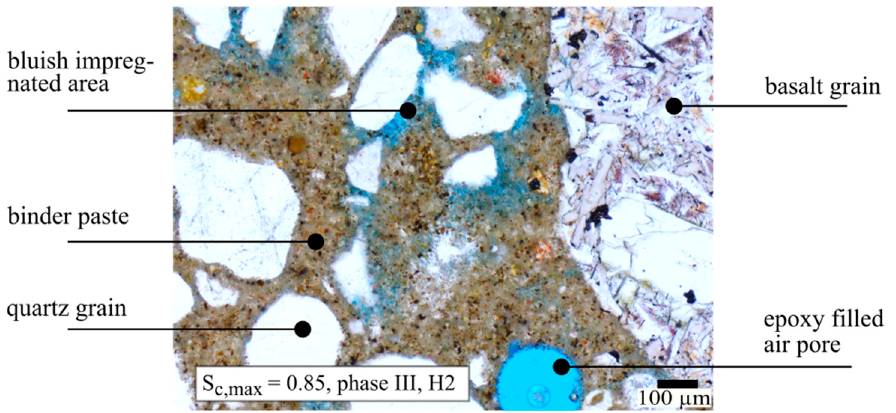
Figure 5. Light microscopic image of preloaded high-strength concrete (S c,max = 0.85, phase III, H2). Bluish impregnated matrix areas indicate regions with a higher porosity or possible microdefects. Automatic segmentation of the images was not feasible because the bluish impreg- nated areas were not sharp-edged. Therefore, the bluish impregnated areas were marked manually using Inkscape and further automatically threshold segmented and analysed using the data visualisation software Avizo (ThermoFisher Scientific, Waltham, MA, USA). The number of segmented (i.e., bluish) areas for each ROI was counted and their respective area and total sizes were determined. The results for the horizontally orientated thin sections H1 and H2 of the same maximum stress level and fatigue phase were averaged. The vertically orientated thin sections V1 were considered